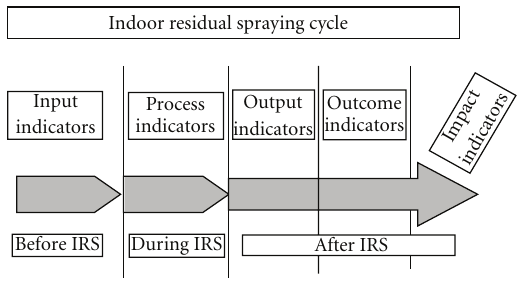
Figure 1: M&E toolkit for